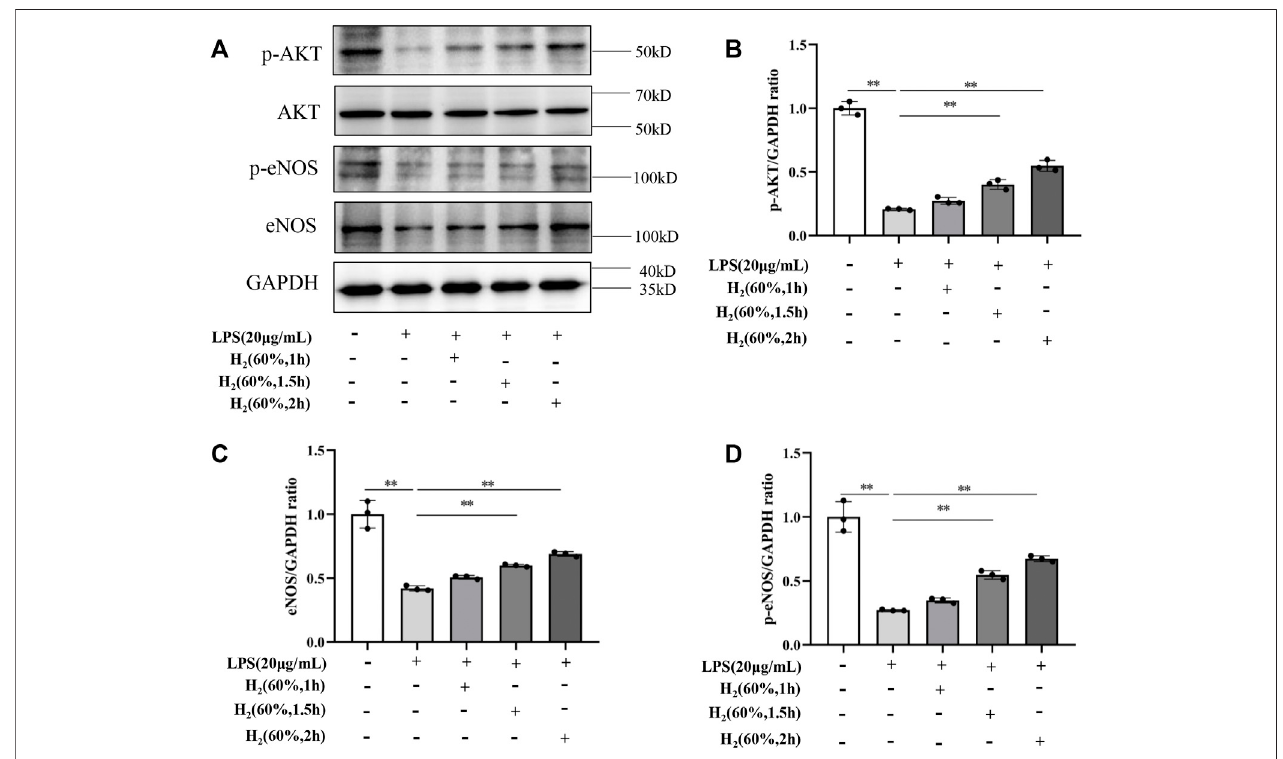
FIGURE5|(A) Representativewesternblotimages.H 2 up-regulatedthelevelsofp-AKT (B) ,eNOS (C) ,andp-eNOS (D) inEPCsatdifferenttimepoints.Cellswere treated with LPS (20 μ g/ml) and H 2 (60%) for 0, 1, 1.5 and 2 h, respectively. Western blotting was used to detect the expression levels of target protein. Data are presented as mean ± SD; ** p <